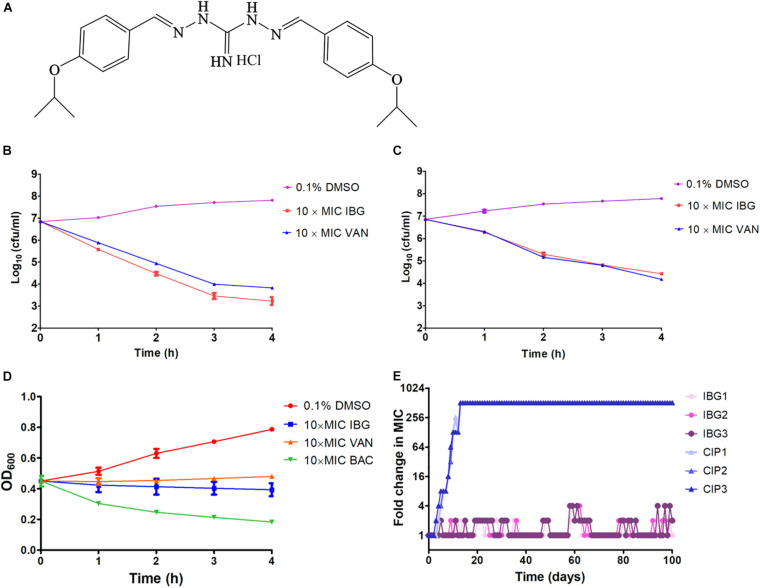
IBG inhibits S. aureus growth without detectable mutant development. (A) Structure of IBG. (B) Viability of S. aureus ATCC 29213 treated with IBG or VAN. (C) Viability of MRSA ATCC 43300 treated with IBG or VAN for 4 h. (D) IBG treatment could not result in S. aureus ATCC 29213 lysis; (E) Appearance of spontaneous IBG and CIP-resistant S. aureus mutants over 100 days of serial passages. IBG, isopropoxy benzene guanidine; VAN, vancomycin; CIP, ciprofloxacin; Individual data points (n = 3 biologically independent experiments) and mean ± SD. are shown.